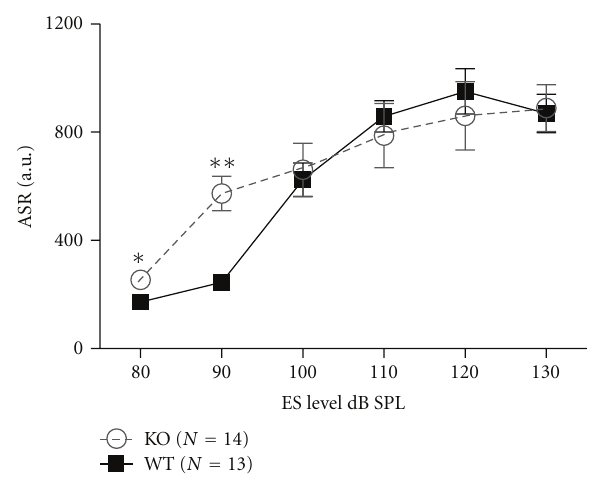
Figure 6: Acoustic startle response in WT and prestin KO animals. The startle response to brief loud sounds increases with sound level for both genotypes, with the prestin KO mice showing significant hyper-excitability at the lower ES